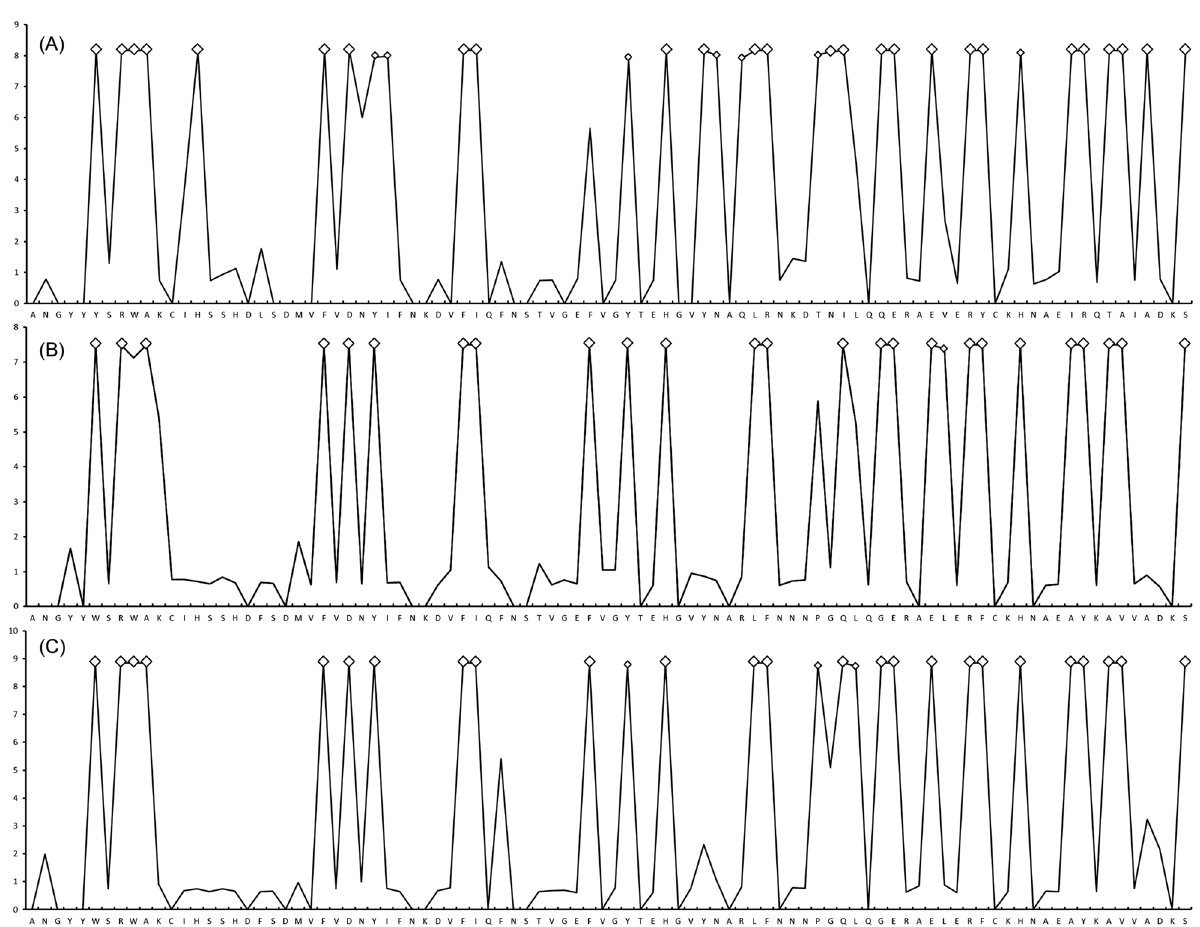
Figure 3. Approximate posterior means of ω calculated as the weighted average of ω over the 11 site classes and weighted by the posterior probabilities under the M8 site-model are shown for DAB sequence variants for ( A ) A. brama , ( B ) R. rutilus , and ( C ) their respective hybrids. Sites inferred to be under positive selection at the 99% level are indicated by large white squares and those at the 95% level are indicated by small white sites in DAB sequences. Log-likelihood values and parameter estimates under random-site models are shown in Supplement S2. On the basis of BEB analysis, 24 and 33 PSS in bream were identified using the M2a and M8 models respectively, whilst 25 sites using the M2a model and 26 sites using the M8 model were identified under positive selection in roach. The Bayes identification of sites under positive selection calculated using the M8 model is included in Fig. 3. The same 24 PSS under the M8 model were identified in both species. In addition, next 9 codons only in bream and 2 codons only in roach were identified under positive selection. The pattern of PSS distribution in hybrids was intermediate between bream and roach. The 24 PSS shared by bream and roach were also identified in hybrids. In addition, one codon under positive selection was shared by both bream and hybrids, and one codon under positive selection was shared by roach and hybrids. A single codon was identified under positive selection solely in hybrids. Associations between MHC genes and parasites. Parasite data for fish analysed for MHC diversity are included in Table 3. No significant covariance between MHC alleles and parasite species data or parasite groups data was found using COIA for each of bream, roach, and hybrids separately ( p > 0.05). No significant covariance between MHC alleles and parasite groups was found when including all fish groups into analysis ( p > 0.05) (Supplement S3). Similarly, no significant covariance between MHC supertypes and parasite groups data (Supplement S4) was found when including all fish in the analyses or when analyzing common bream, roach or hybrids separately ( p > 0.05). When COIA was performed including MHC alleles and all fish groups (bream, roach, and hybrids), the DAB alleles and metazoan parasite species exhibited significant covariance in the COIA model (RV = 0.16, p < 0.003). The two first axes of the COIA (F1 and F2) accounted for 75.05% of the total variance shared between the two matrices (F1 65.99% and F2 9.06%). Comparison between the distribution of parasitological and genetic variables on the COIA factor maps revealed species-specific associations (Fig. 4). Correspondence analysis row scores on F1 separated bream and roach individuals on the basis of their specific MHC alleles and host-specific parasite species (Supplement S5).